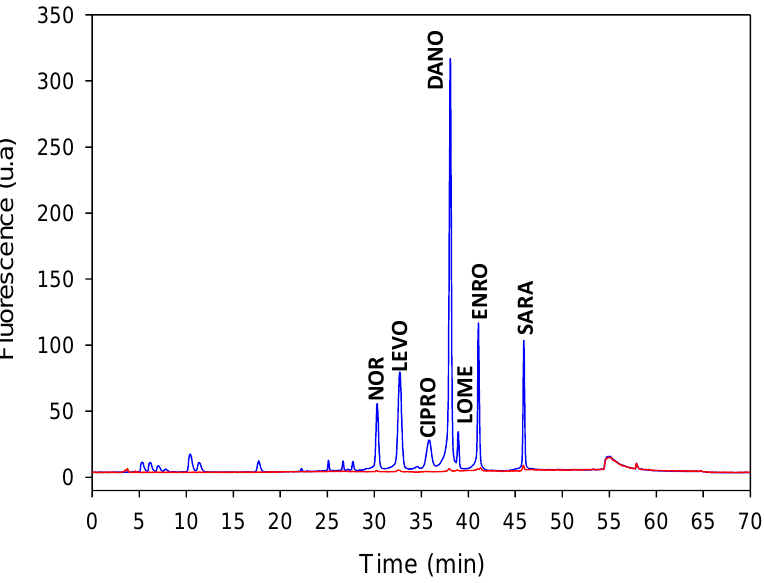
Figure 4. Chromatograms of target FQs in the MIP (blue line) and NIP (red line). FQs concentration: 67 ng L − 1 . Loading volume: 150 mL of water.